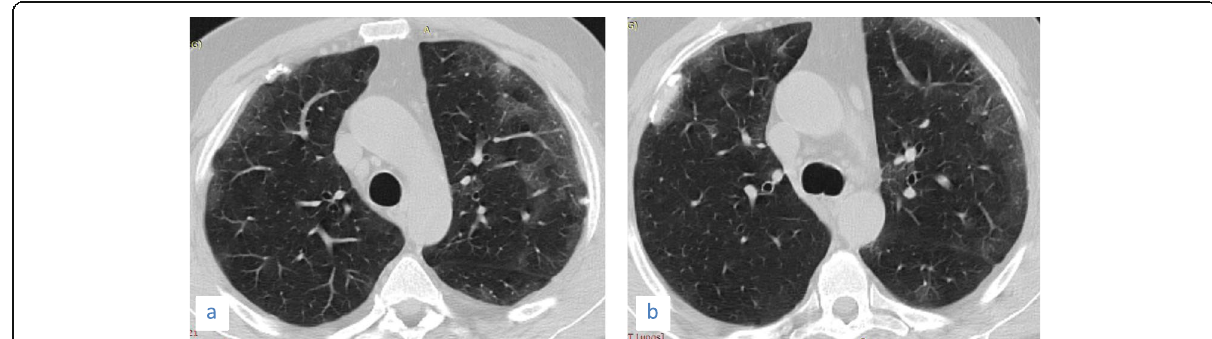
Fig. 5 Male patient 56 years old with COVID-19. CT axial images ( a ) and ( b ) show bilateral predominantly peripheral rounded ground glass